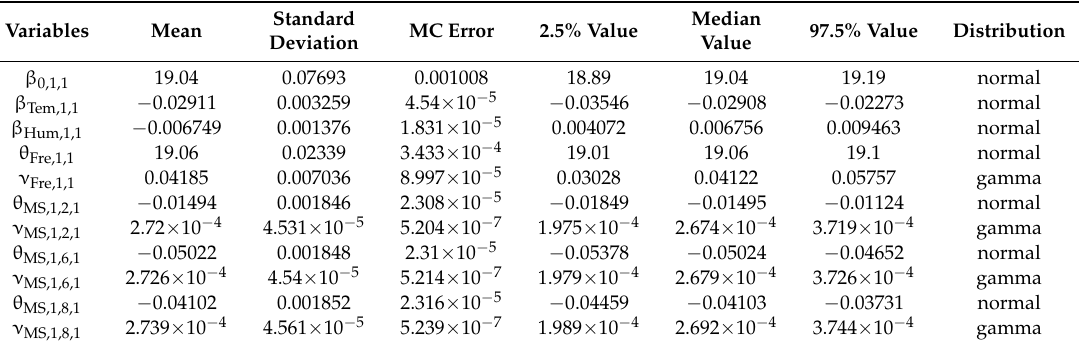
Table 5. Dynamic Bayesian network results in Time